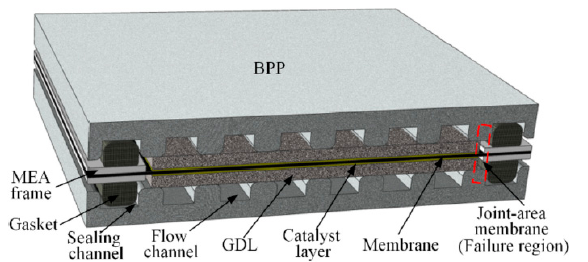
Figure 1. Schematic diagram of PEMFC and failure area [12].